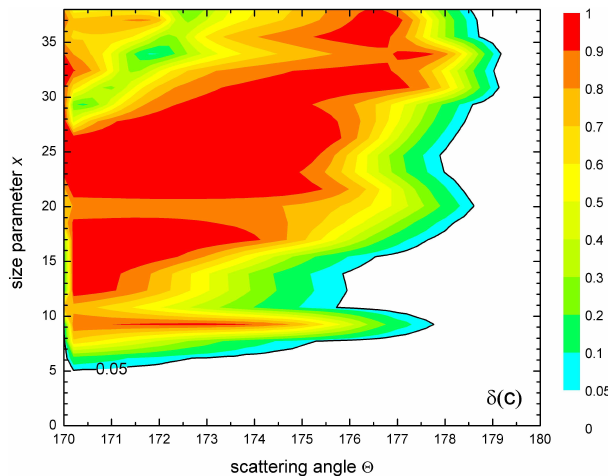
Fig. 4. Depolarization ratio δ C for spherical particles as a function of the scattering angle 2 and the size parameter x .